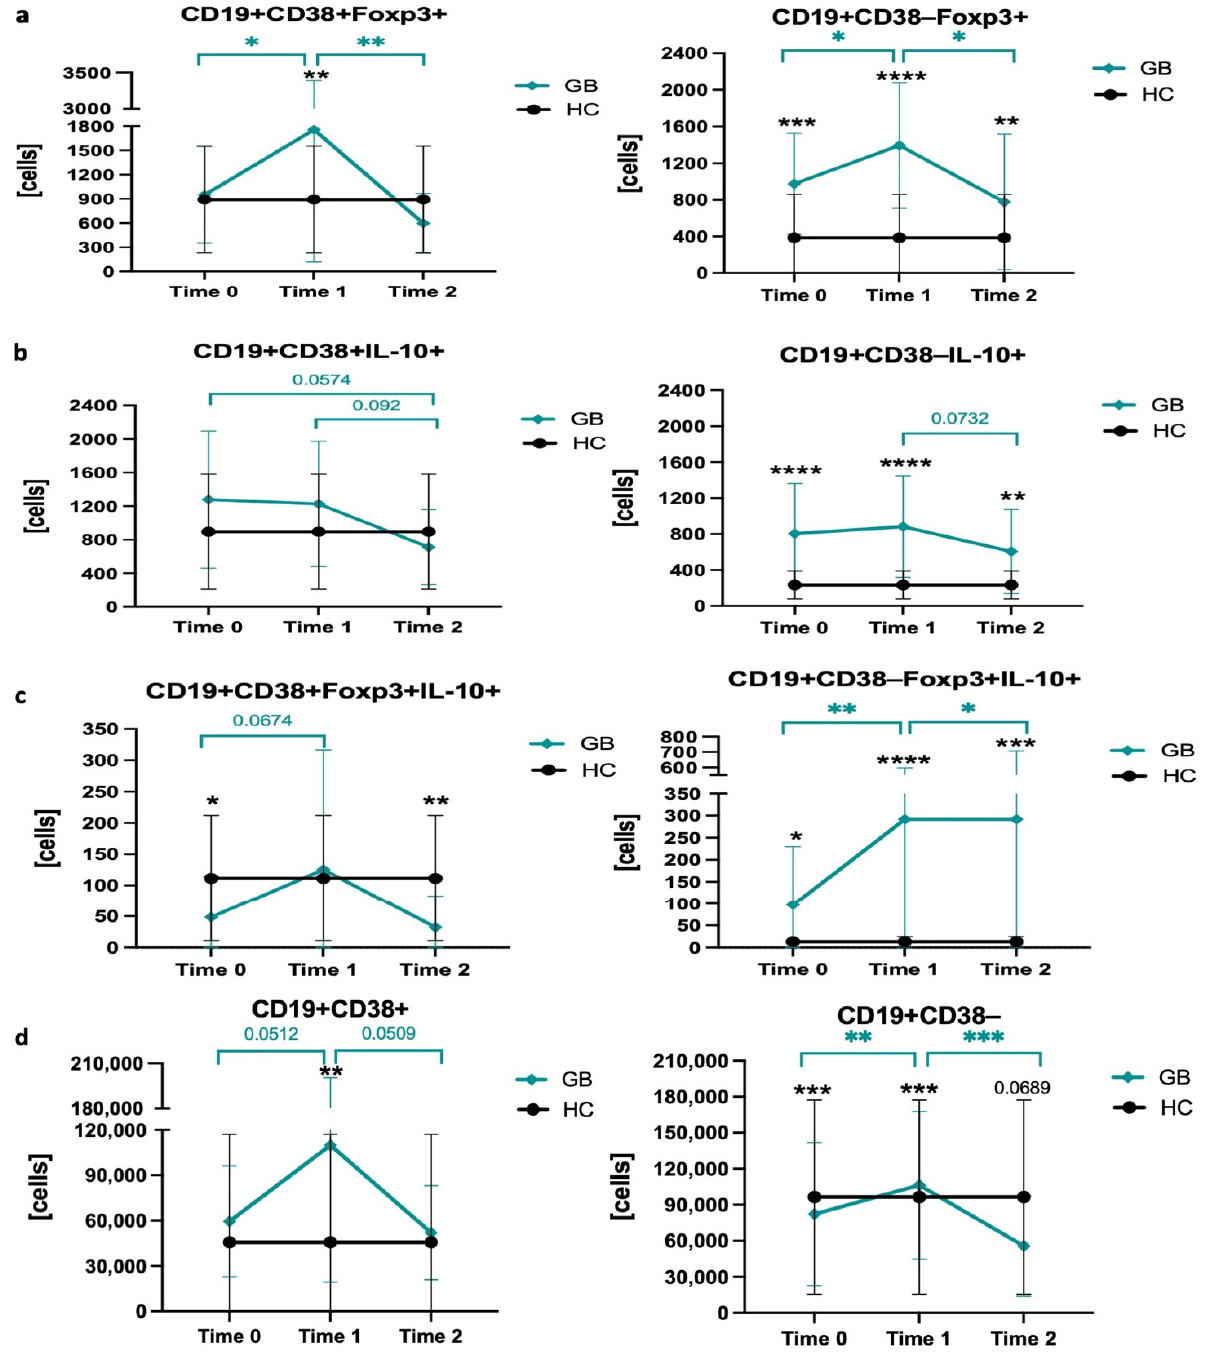
Figure 3. Methimazole treatment effects on distribution of regulatory B cells in Graves’ patients and healthy control group. Selected Breg populations were monitored for up to 3 months (Time 0) and then controlled after a 1–2-year interval (Time 2), with pretreatment values included (Time 0). Regulatory B cell subsets were distinguished based on differential CD38 marker expression and the presence of Foxp3 ( a ), IL-10 ( b ), co-expression of Foxp3 and IL-10 ( c ). Additional changes in CD38 expression within CD19+ B cells were included ( d ). Data are presented on each graph as mean with standard deviation. Significant differences are highlighted with asterisks or direct values: black—when comparing Graves’ to control group at a certain time point, and aquamarine—for changes in the course of therapy within Graves’ subjects. Significant data are indicated with asterisks: * p < 0.05, ** p < 0.01, *** p < 0.001, **** p < 0.0001.